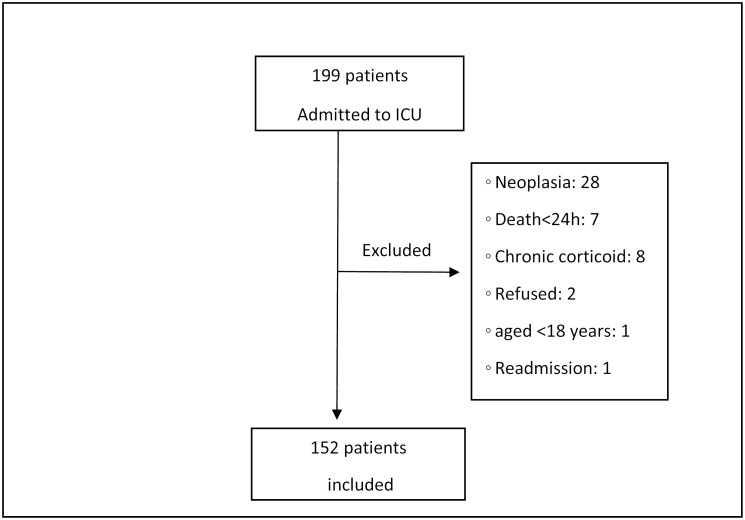
Flowchart of patients.